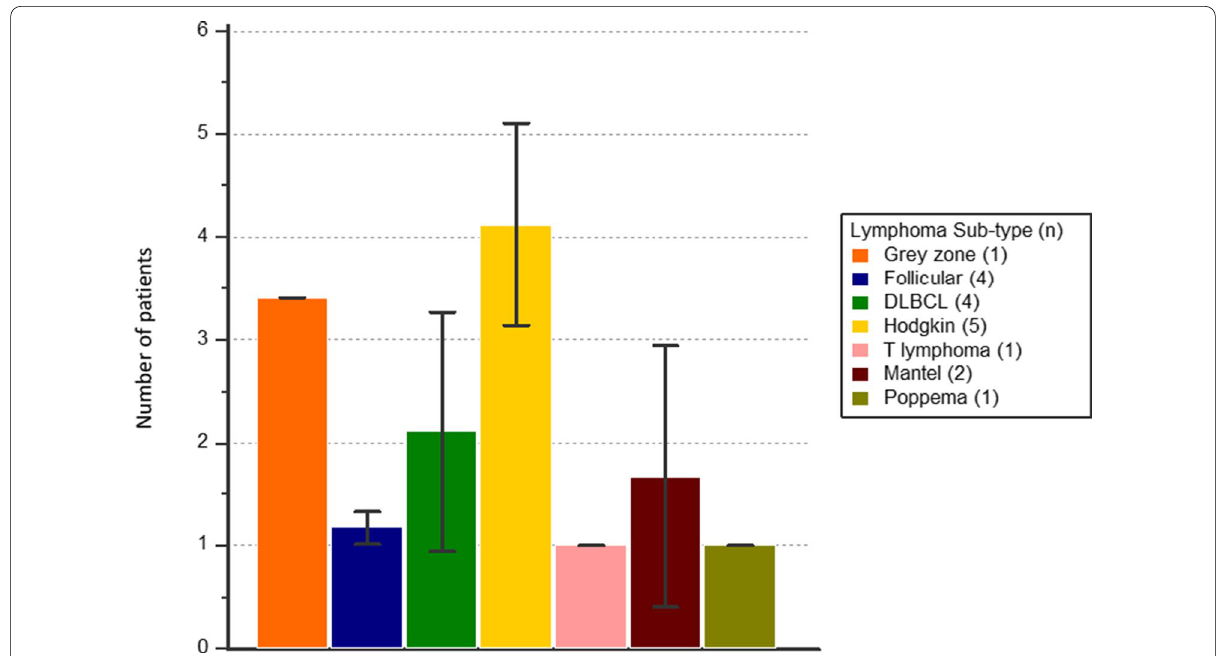
Fig. 2 C0 RGD uptake according to histological